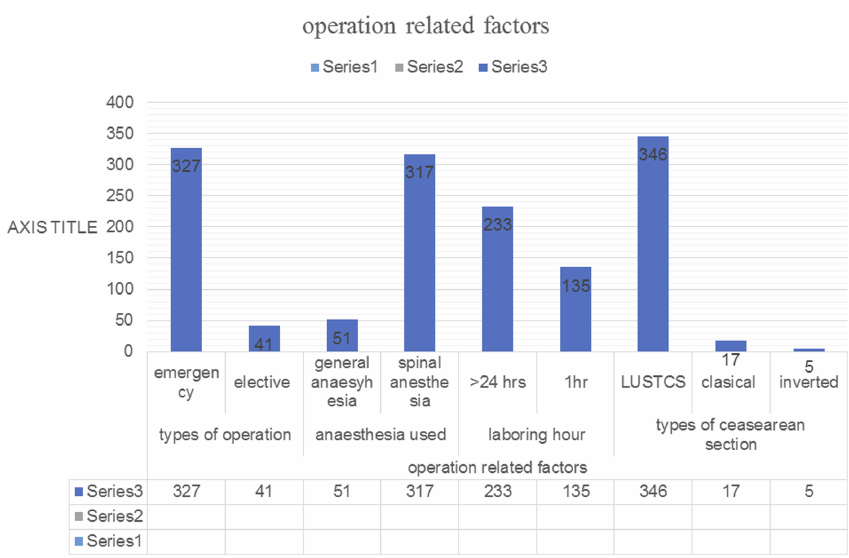
Figure 1. Types of